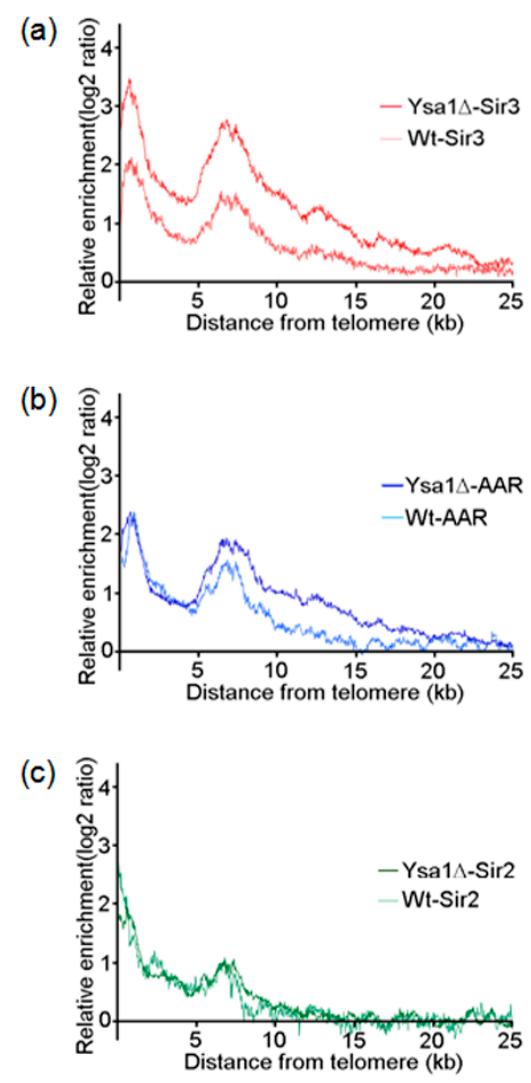
Figure 4. Occupancies of AAR, Sir2, and Sir3 on telomeres. ( a – c ) The moving averages of Sir3 ( a ), AAR ( b ), and Sir2 ( c ) binding for all 32 yeast telomeres are plotted as a function of distance from the chromosome ends. Binding enhancement was measured as the log2 score of immunoprecipitation versus input. Data are provided for Sir3, AAR, and Sir2 binding in either wild type or ysa1 -deletion cells, as indicated. Cell type: Wt: wild-type strain; ysa1 Δ : ysa1 -deletion strain.